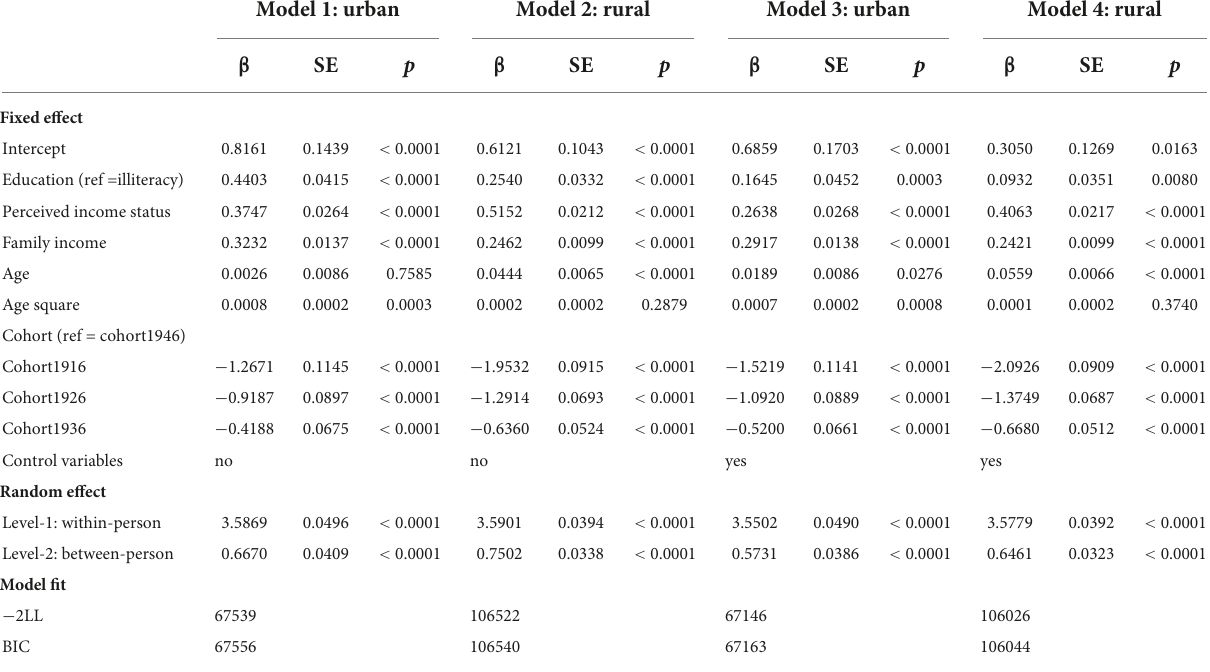
TABLE 3 Association between age, cohort, and dietary diversity score (DDS) in Chinese older adults. Model 1: